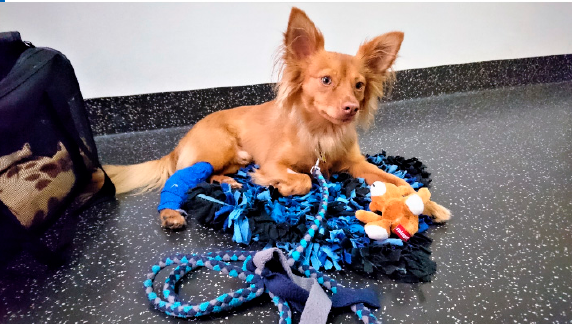
Figure 2. Owners can be advised to bring a blanket from home and to distract the animal with food or toys in order to decrease stress during the waiting time. However, the potential for resource guarding when using toys or chews needs to be considered. Not suitable when sufficient spacing between animals in the waiting area is not possible. Photo: Stefanie Riemer.